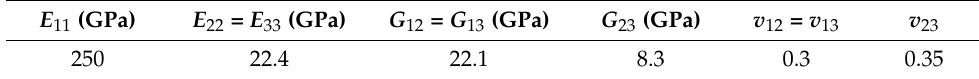
Figure 4. The 3D square representative UC of the impregnated fiber tow. Table 2. Elastic properties of carbon fiber used in the microscale analysis.